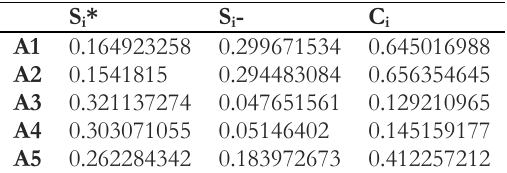
Table 8. TOPSIS decision matrix showing the best